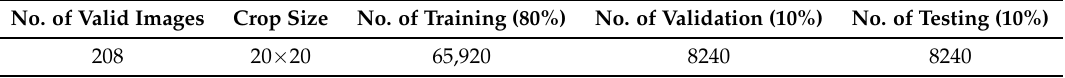
Table 2. Composition of the spectral brightness temperature data for deep learning.